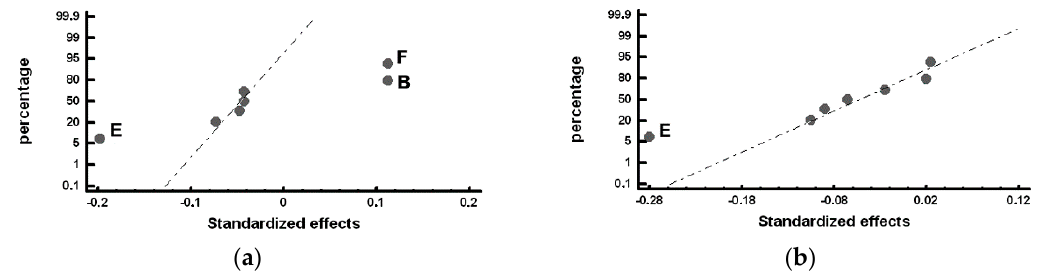
Figure 5. Standardized effects on the Roundness parameter, R , on a normal probability plot: ( a ) Factors with a significant effect on the outermost region of the working layer (Zone α ); ( b ) Factors with a significant effect on the inner region of the working layer (Zone β ).